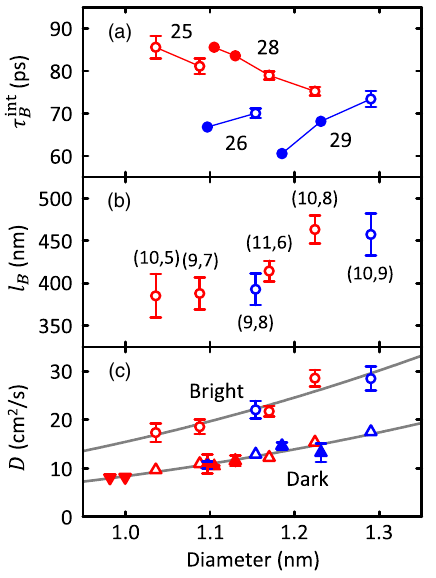
FIG. 3. (a) Diameter dependence of τ int . Open circles are B obtained from the length-dependence fit, and filled circles are the longest effective lifetimes measured within the same chir- alities. Chiralities with the same family number ( 2 n þ m ) are connected, and the family numbers are displayed. (b) Diameter dependence of l . The chiral indices are shown for each data B point. (c) Diameter dependence of D for bright excitons (open circles) and dark excitons (triangles). The filled triangles are estimated from a limited number of CNTs, where up and down triangles are obtained from two and one data points, respectively. Gray lines are fit results with a power-law function. (a) – (c) Red and blue symbols correspond to type 1 and 2 chiralities, respectively, and the error bars show the standard error of the fits. Error bars for the open triangles in (c) are not shown as they are smaller than the